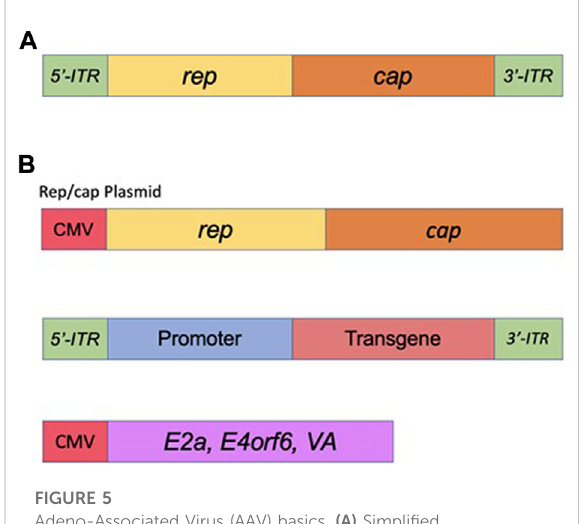
FIGURE 5 Adeno-Associated Virus (AAV) basics. (A) Simpli fi ed schematic of the wild-type AAV genome. (B) Plasmids used in the current AAV packaging system. See the main text for a detailed description of the AAV packaging